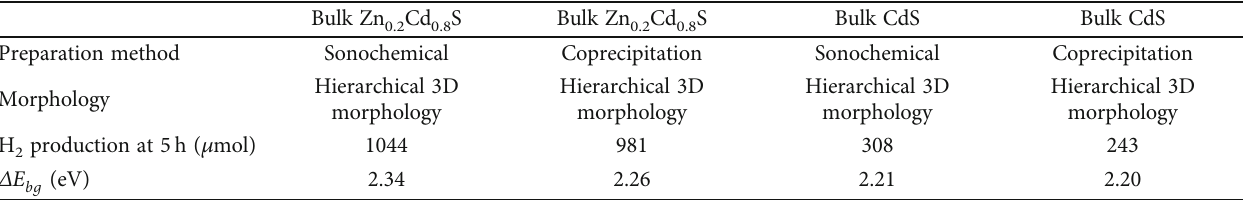
Table 4: Comparison of some characteristics of unsupported and supported Zn the same conditions a